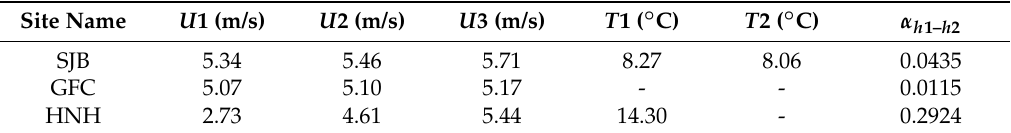
Table 7. Wind data